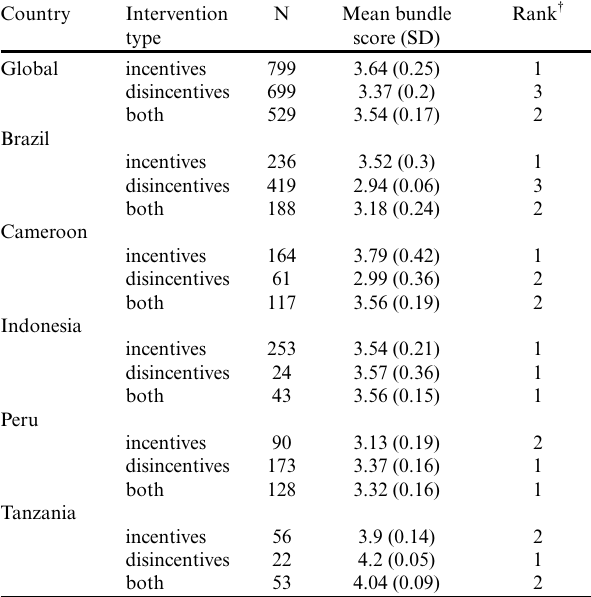
Table 6 . Household-level average (and standard deviation) of well-being scores for the different intervention